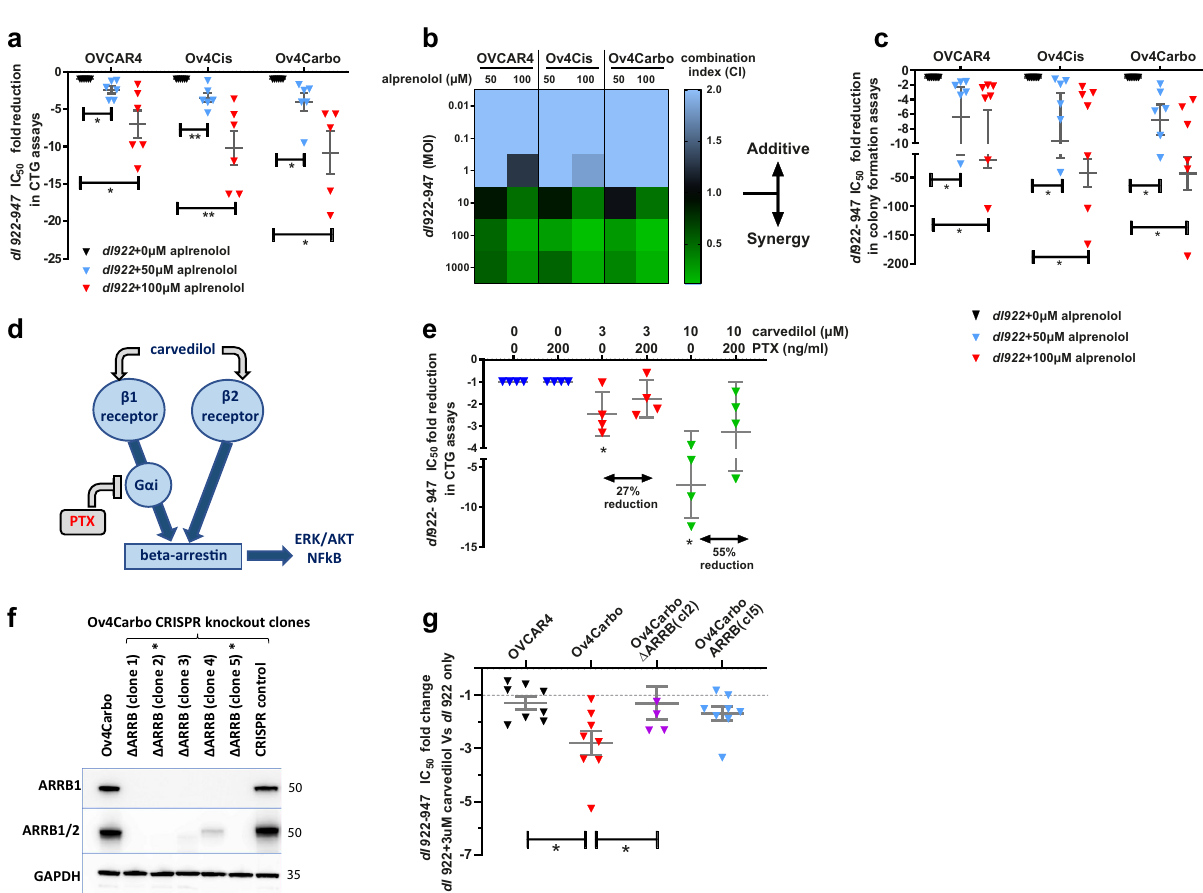
Fig. 3 Synergy between carvedilol and dl 922-941 is mediated by β -arrestins. a Fold reductions of dl 922-947 IC 50 in CTG assays following alprenolol treatment compared to virus alone in the OVCAR4 cell line panel ( n = 6 biological repeats; mean ± SEM; unpaired t -test, * P ≤ 0.05; ** P ≤ 0.01). b Heatmap of the combination indexes between alprenolol and dl 922-947 calculated from ATP-based viability assays. c Fold reductions of dl 922-947 IC 50 in colony formation assays following alprenolol treatment compare to virus alone in the OVCAR4 cell line panel ( + vehicle: n = 6; + 50 μ M: n = 6; + 100 μ M: n = 7 biological repeats; mean± SEM; Wilcoxon matched-pairs signed rank test; * P ≤ 0.05). d Schematic representation of carvedilol-induced β -arrestin signalling. e Fold reductions of dl 922-947 IC 50 in CTG assays following carvedilol and pertussis toxin (PTX, 200ng/ml) treatments compared to virus + carvedilol in the OVCAR4 cell line panel ( n = 4 biological repeats; mean ± SD; unpaired t -test; ns P > 0.05; * P ≤ 0.05). f Representative western blot of β -arrestin expression in Ov4Carbo arrestin-knockout clones. g Fold reductions of dl 922-947 IC 50 in CTG assays following 3 μ M carvedilol treatment in the Ov4Carbo β -arrestin-knockout clones (OVCAR: n = 8; Ov4Carbo: n = 8; Δ ARRB(cl2): n = 5; Δ ARRB(cl2): n = 8 biological repeats; mean ±SEM; unpaired t- test relative to Ov4Carbo, * P ≤ carboplatin (Supplementary Fig. 6b) and dl 922-947 (Supplemen-